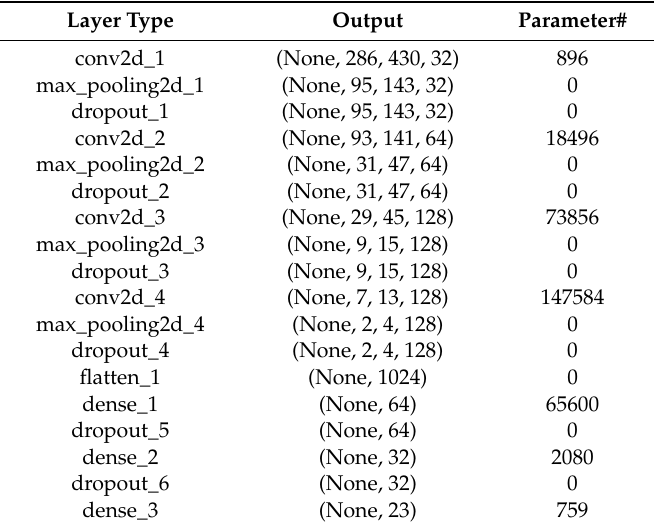
Table 4. The layer structure of CNN2d for 30 measurements.